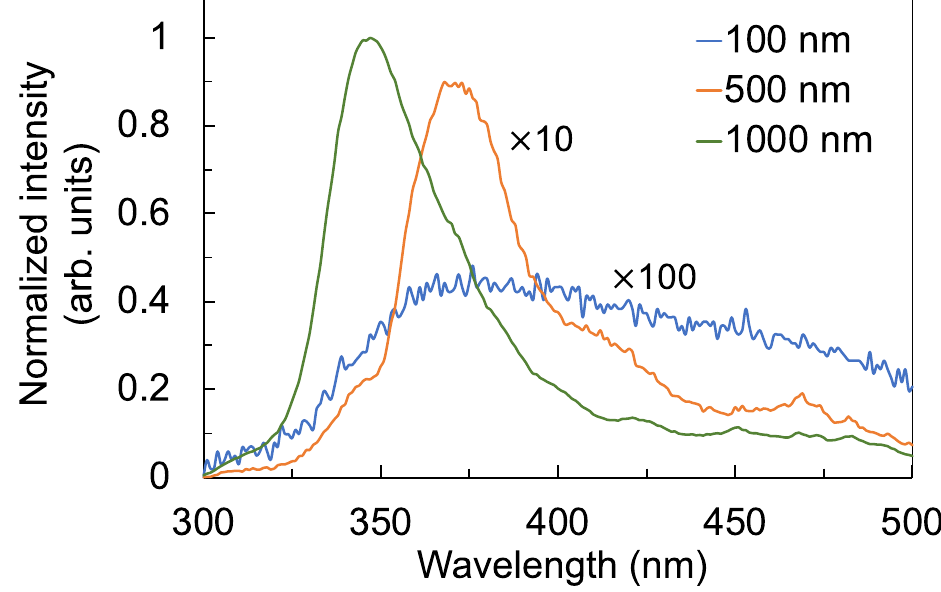
Figure 8. Photoluminescence emission spectra of the TiO 2 thin films with thicknesses of 100 nm, 500 nm, and 1000 nm under 260 nm UV-C excitation. The luminescence intensity of the 500 nm and 100 nm films were zoomed-in by a factor of 10 and 100, respectively, for ease of comparison.